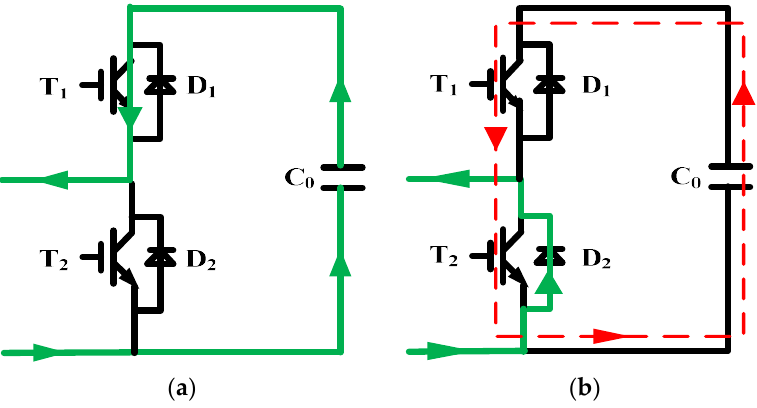
Figure 3. Current path when T 1 is short-circuit with i arm < 0: ( a ) S = 1; ( b ) S = 0.